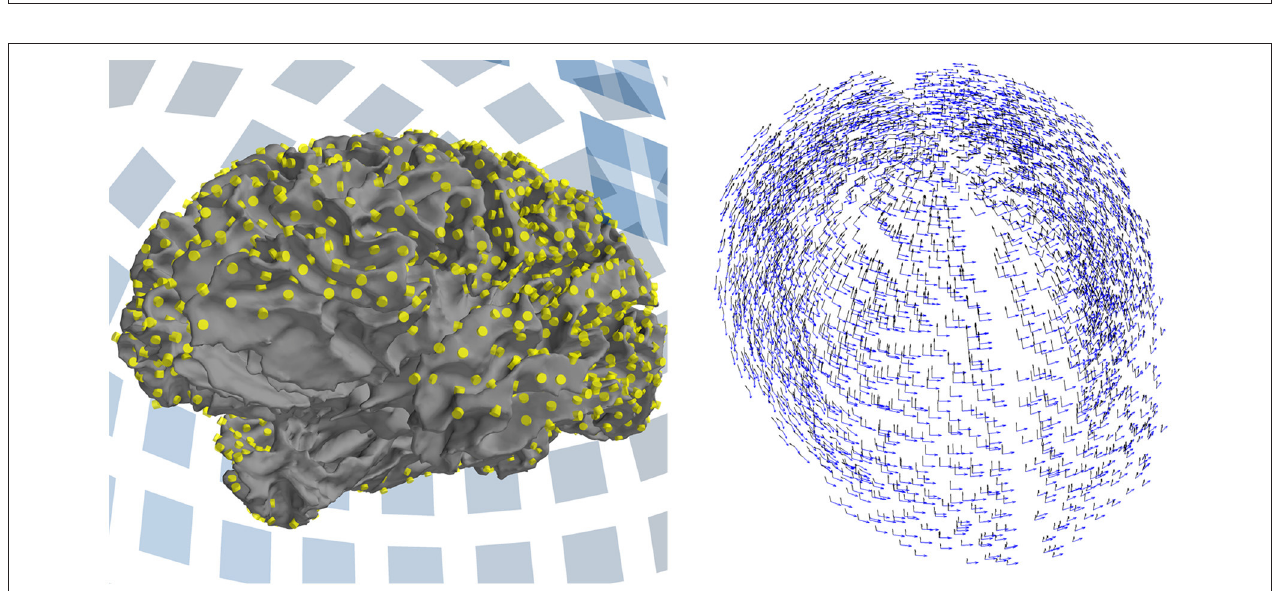
FIGURE 2 | The source space and forward model used in connectivity analysis. (Left) The white matter surface, as reconstructed by FreeSurfer. The source space is defined as a grid of points along this surface, shown in yellow. All points further than 7cm from the closest MEG sensor (shown as blue squares in the background) have been discarded. (Right) The forward model defines two dipoles at each source point. The orientation of the dipoles is tangential to a sphere with its origin at the center of the brain.